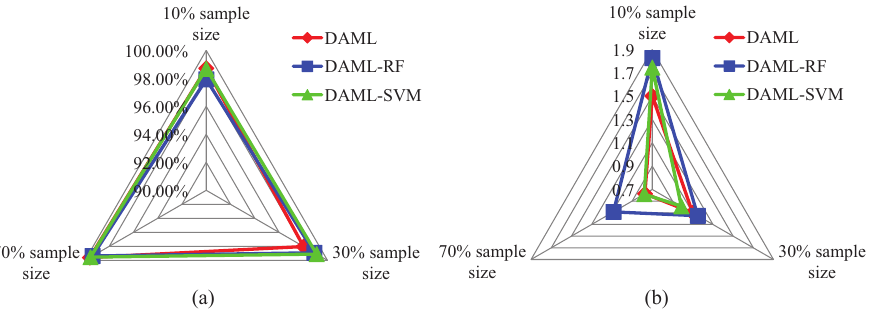
Figure 10. ( a ) Average classification accuracies of DAML with different classification methods; ( b ) Stabilities of DAML with different classification